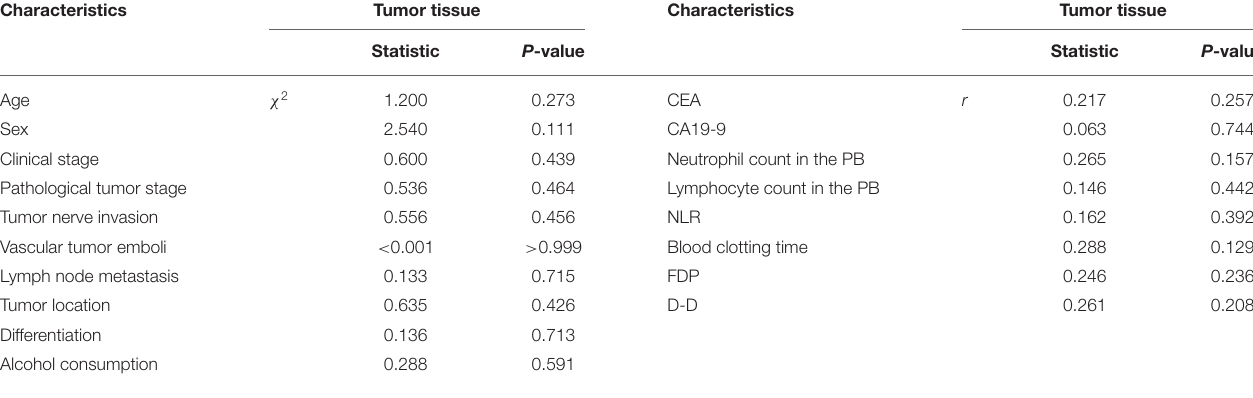
TABLE 7 | The relationships between the levels of NETs in the tumor tissue and clinicopathological features in GC patients. Characteristics